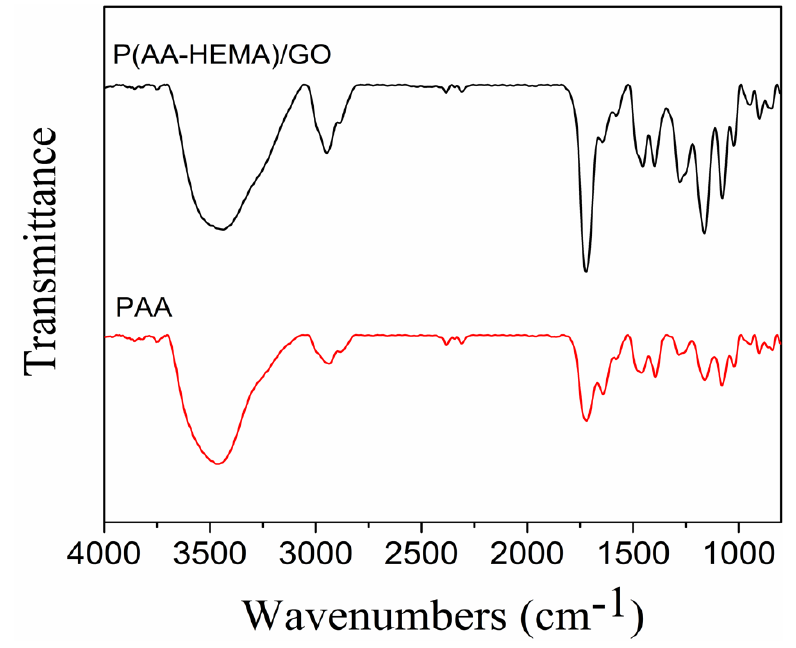
Figure 2. FTIR spectra of P(AA-HEMA) / GO hydrogels ( black ) and PAA hydrogels ( red ).